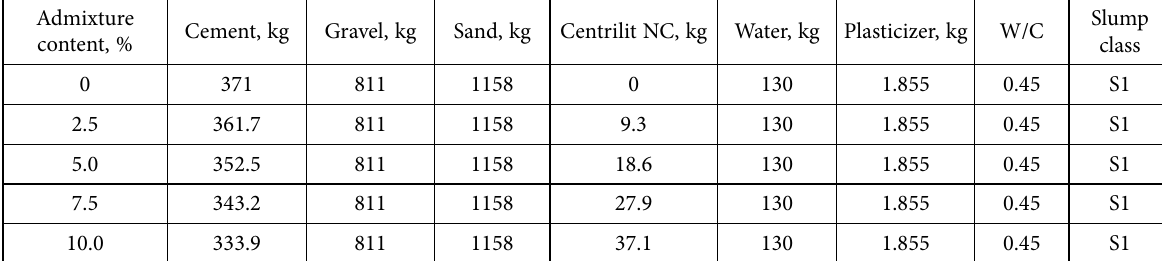
Table 3. Compositions of 1 m 3 of concrete